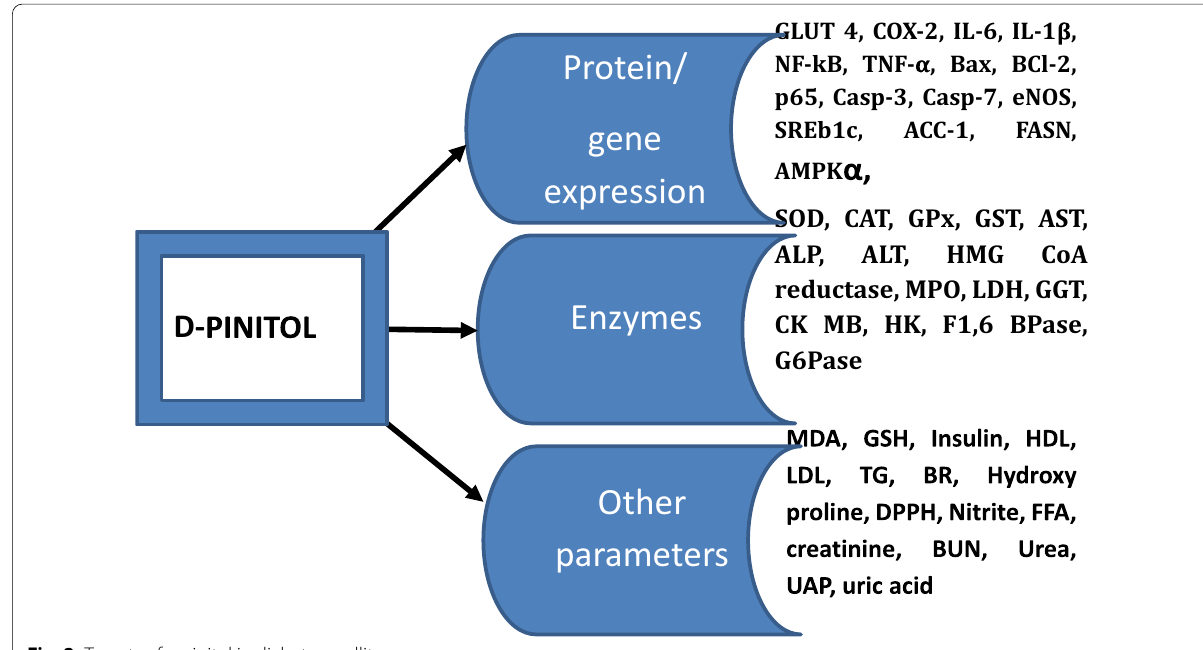
Fig. 2 Targets of d -pinitol in diabetes